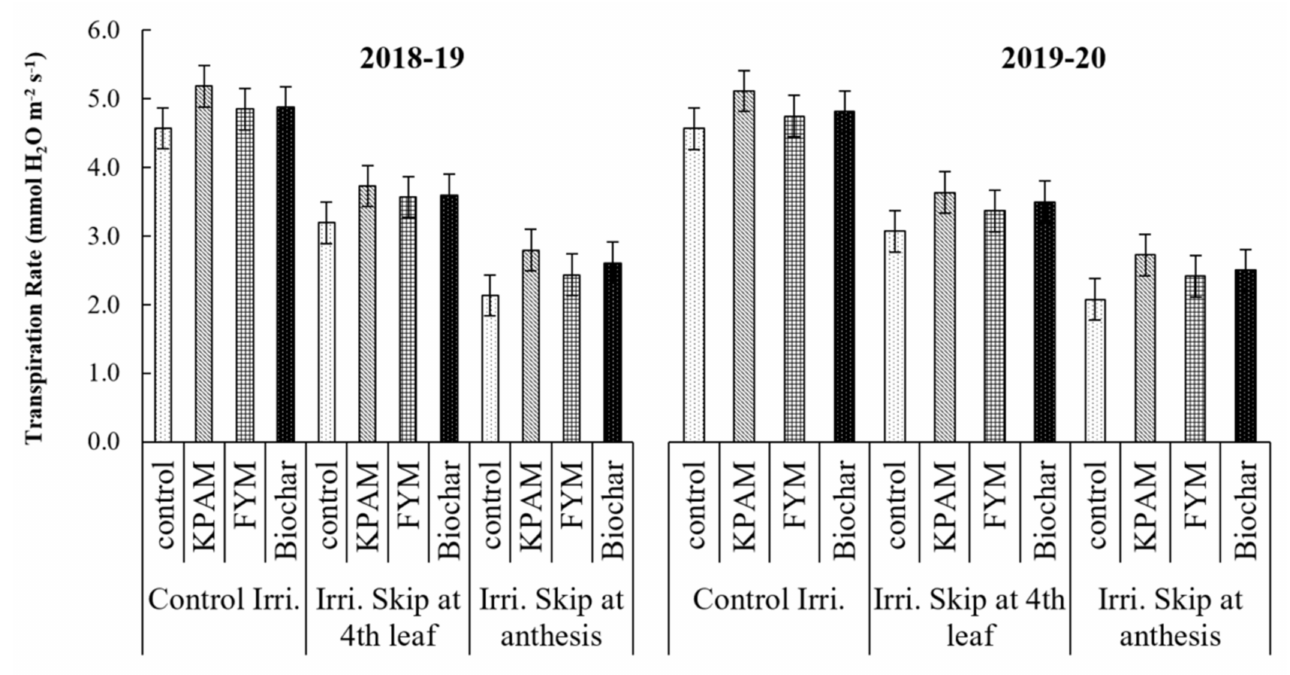
Figure 7. Effect of soil amendment materials on transpiration rate in the wheat crops grown under normal and water stress imposed by skipping irrigation at 4th leaf and anthesis stage of growth (mean values ±